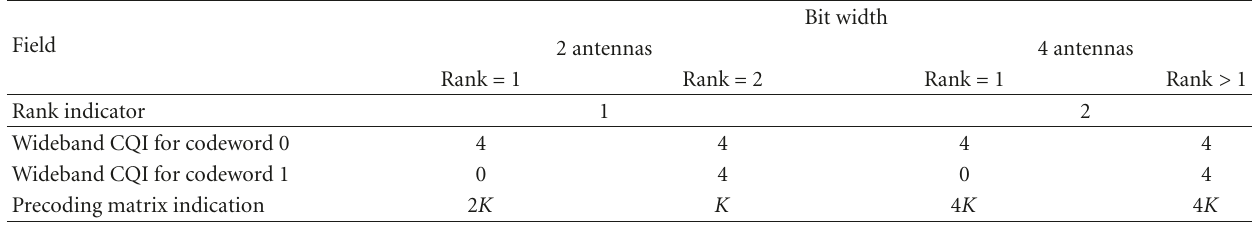
Table 7: Feedback of wideband CQI and subband PMI via PUSCH.